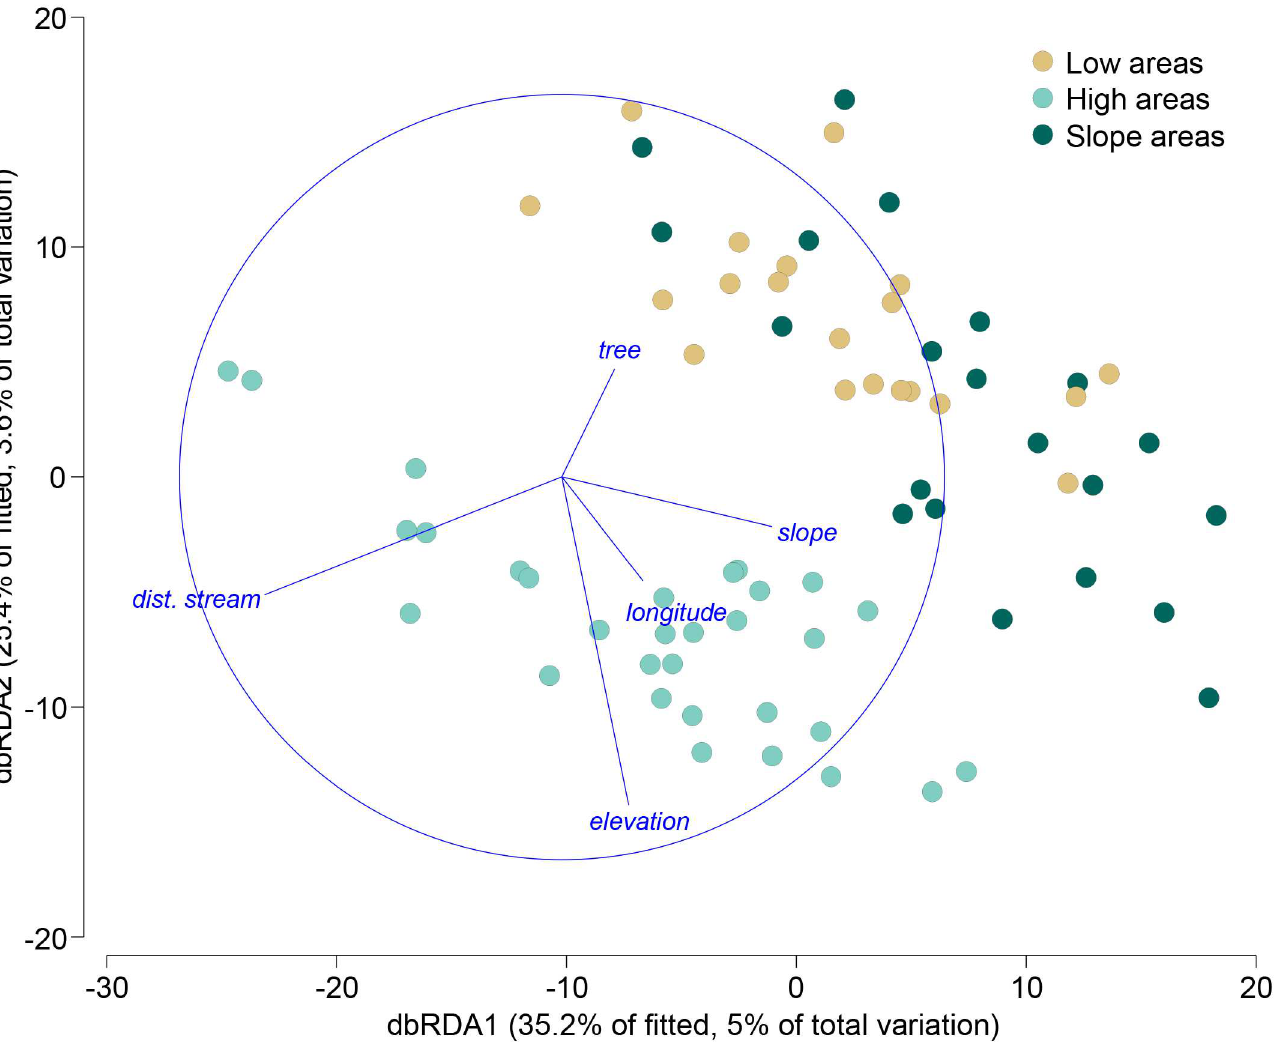
Fig 4. Constrained ordination relating bird data to predictor variables. Distance-based redundancy analysis(dbRDA)of zero-adjusted Bray- Curtis dissimilarities calculatedfrom square-root transformed abundancesof 98 bird species vs. elevation,slope, tree density, distanceto nearest stream, and longitude( x ), identified as the best 5-variablemodel using the AICc selectioncriterion. Colors identify the three environmental